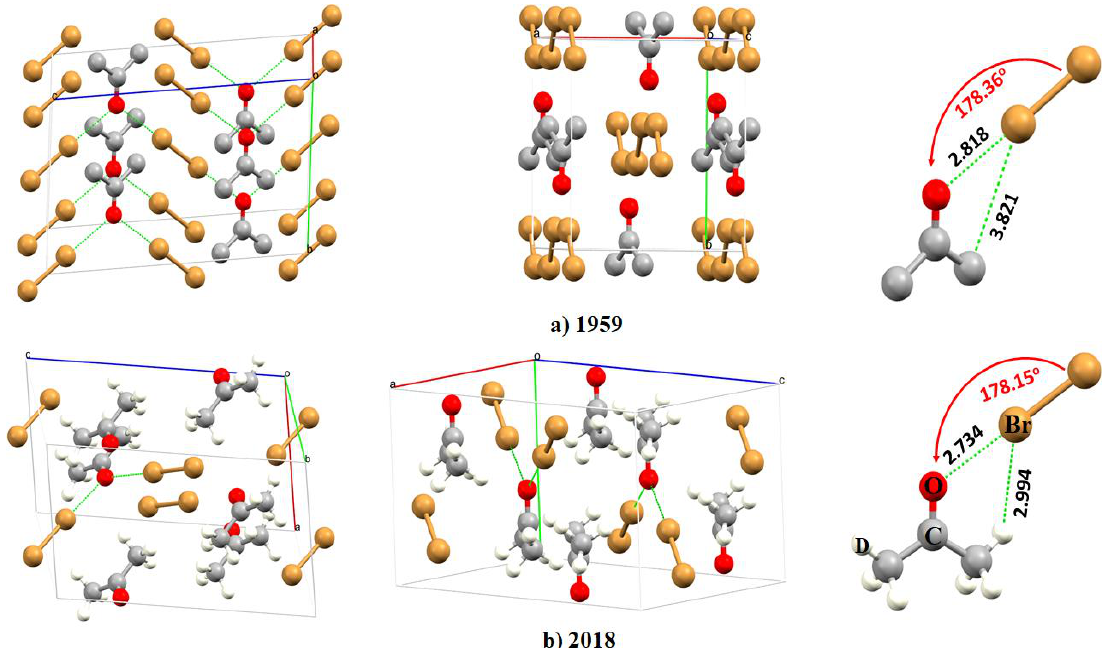
Figure 1. Various views of the ball-and-stick models of the unit cell of the ( a ) acetone–bromine (CSD ref: ACETBR) and ( b ) perdeuteroacetone bromide (CSD ref: ACETBR06) crystals. Atom type is marked in ( b ). Selected bond distances and angles are in Å and degrees, respectively. The dotted lines between atoms indicate intermolecular interactions. Year of publication shown both in ( a ) and ( b ). The H atoms of acetone–bromine are missing in the crystal information file and are not shown.